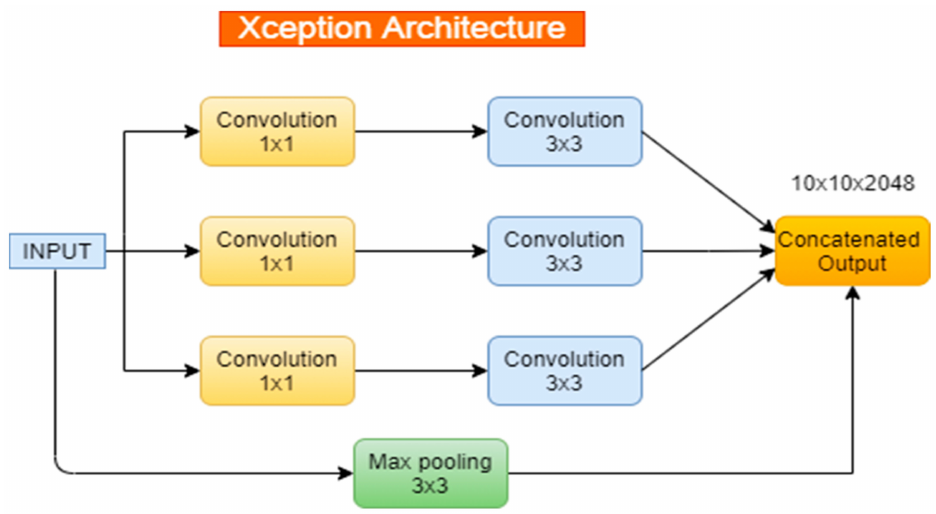
Figure 3. Xception architecture.